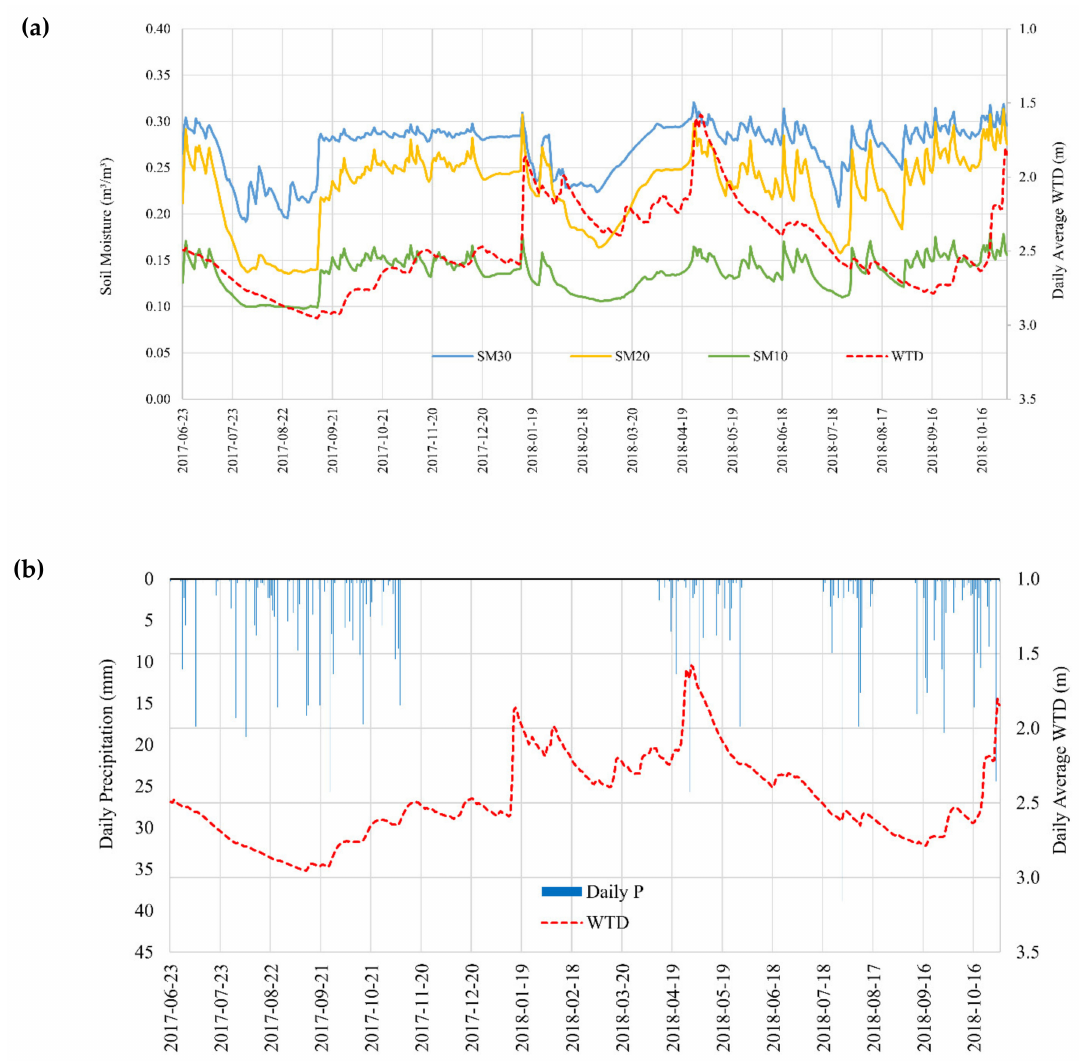
Figure A1. ( a ) Temporal variation of water table depth (WTD) and soil moisture (SM) at three depths measured near the borehole; ( b ) daily rainfall and daily average WTD fluctuation throughout the study